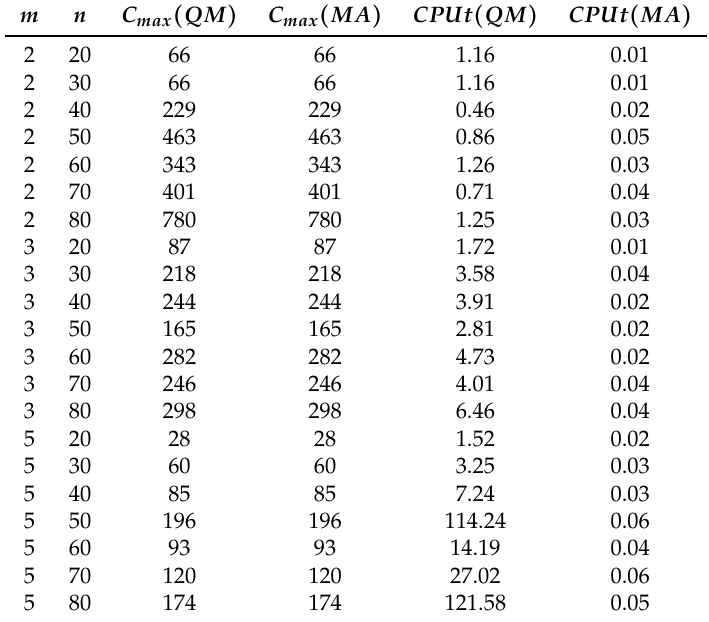
Table 5. Comparison of QM and MA for datasets DS 1 with s i ∈ U ( 1,5 ) and p j ∈ U ( 5,50 ) .